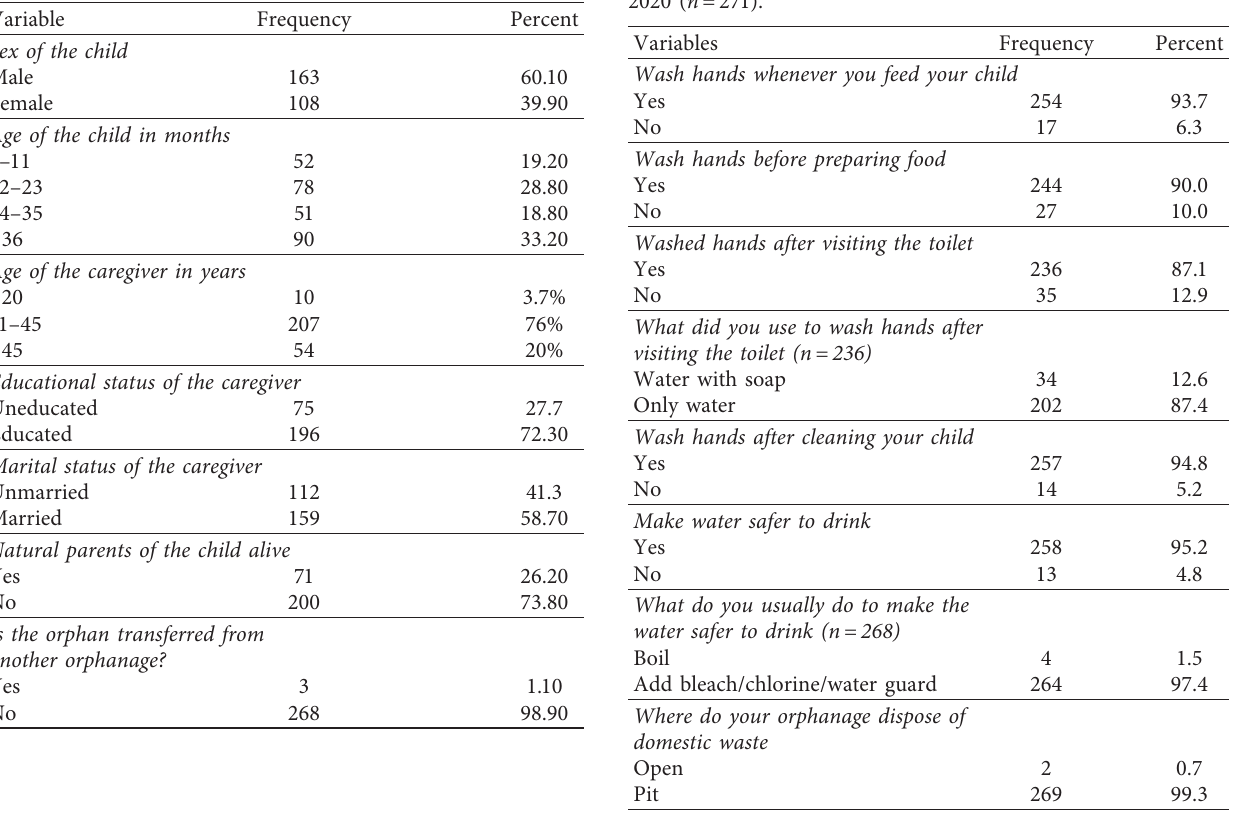
Table 3: Hygienic, sanitation, support, and care characteristics